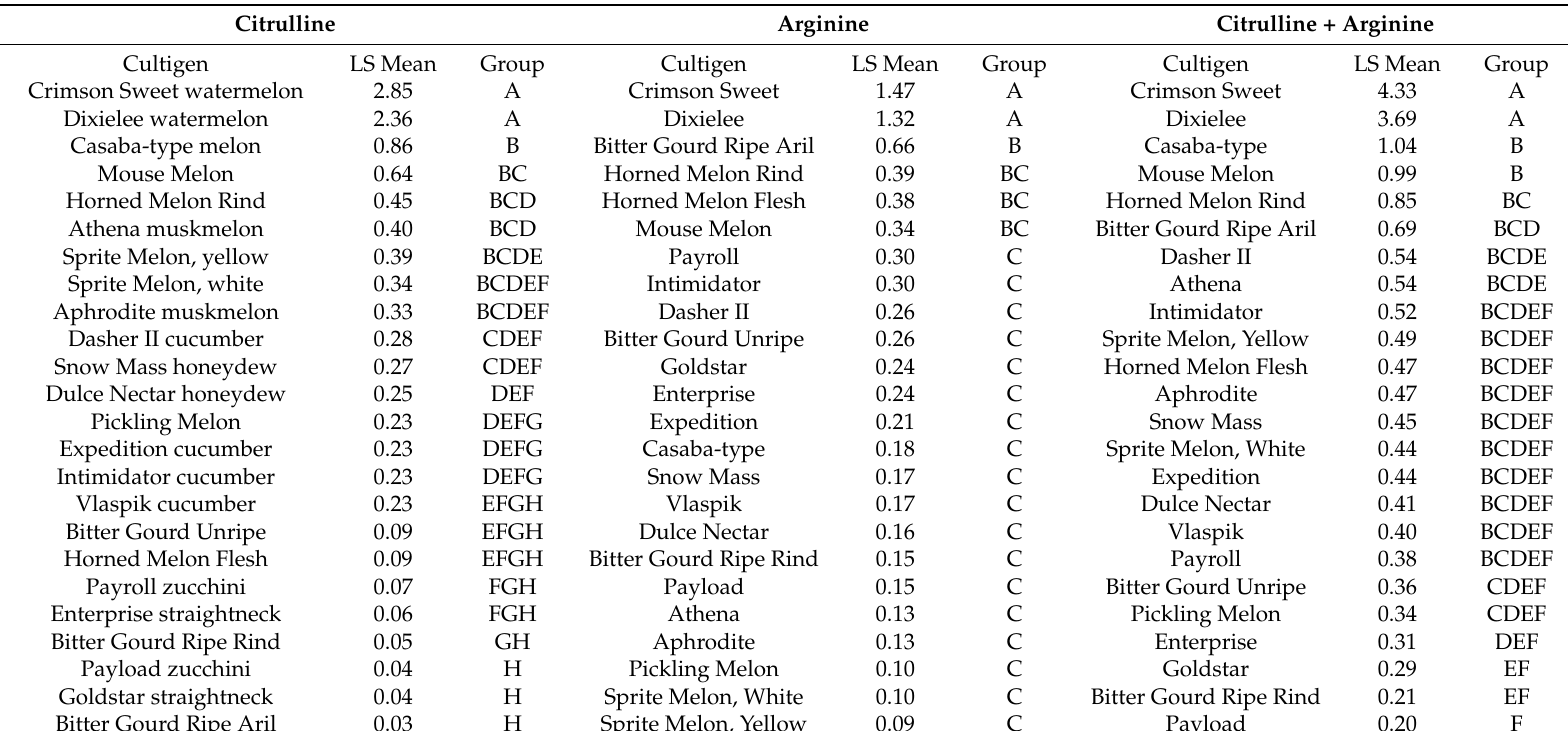
Table 4. LS means for citrulline and arginine content of 21 cucurbit taxa, grouped based on significant differences ( P ≤ 0.05) between LS